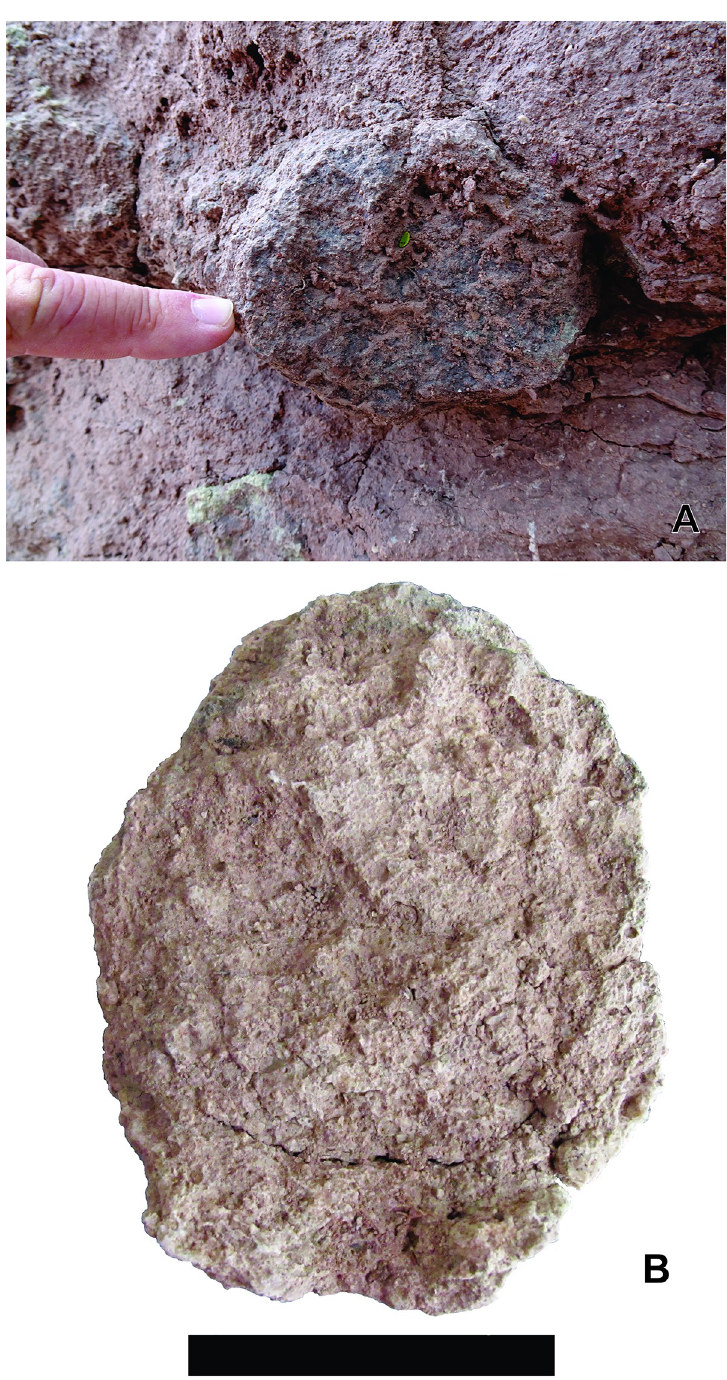
Fig 5. Yaviichnus iniyooensis cross-section of tunnels. (A) Horizontal tunnel cross-section in situ . From “middle beds” strata. (B) Paratype UMPLIC- 386, elliptical cross-section of a tunnel. Scale = 7 mm. burrows are variable, but mostly they are five or six. Vertical and sub-vertical shafts are straight, sinuous, curved or showing successive arches resembling a roughly helical design; they are simple or bifurcated (Fig 8). They extend 8 to 10 m below the chambers. Some vertical